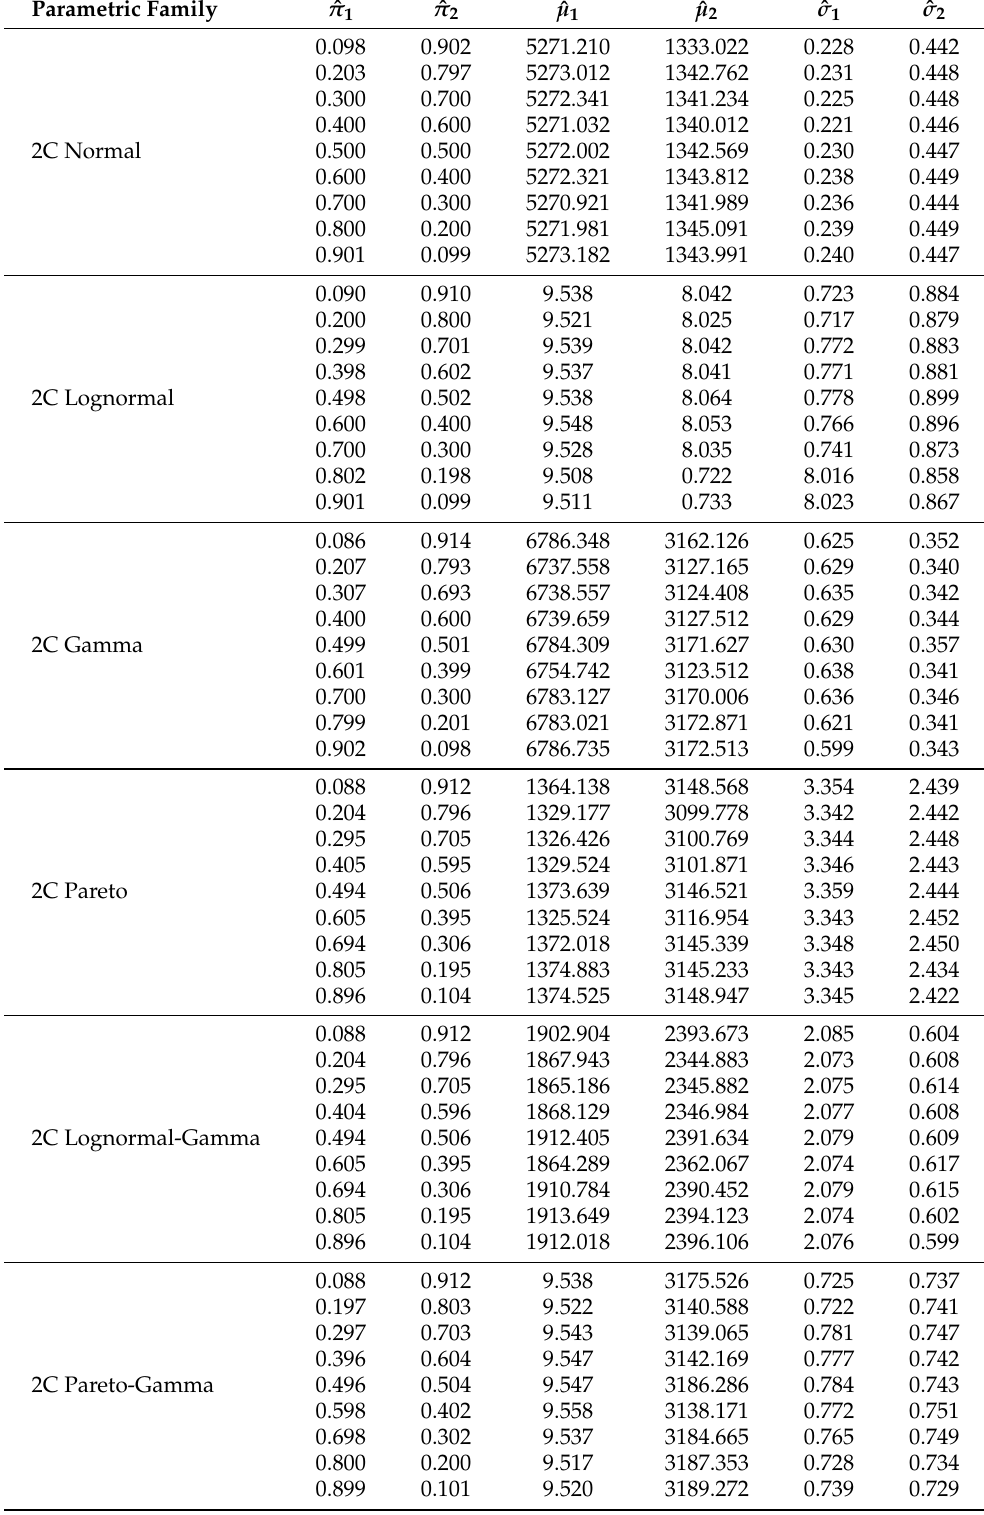
Table 1. EM algorithm estimates for various two-component (2C) finite mixture models. Estimates refer to the parameters mean ( ˆ µ 1 , ˆ µ 2 ) and standard deviation ( ˆ σ 1 , ˆ σ 2 ) and the mixing weights of each mixture component ( ˆ π 1 , 1 − ˆ π 1 ) across all plausible mixing weight combinations ( π 1 ) in the true data generative process. All estimates provided are statistically significant at a 5% threshold or